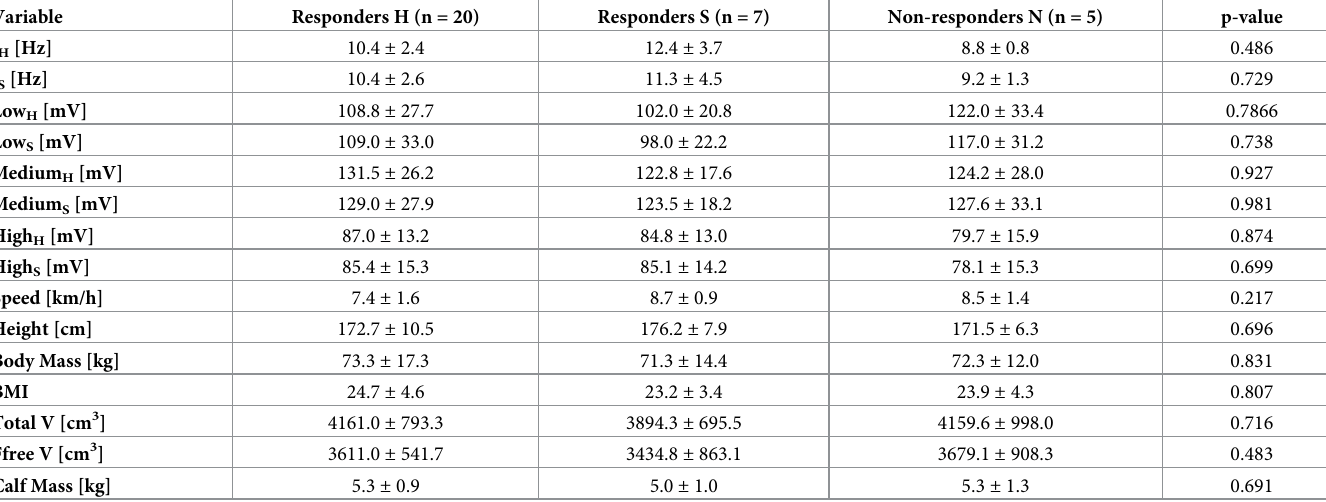
Table 2. Vibration characteristics and anthropometrics after grouping according to damping coefficient.